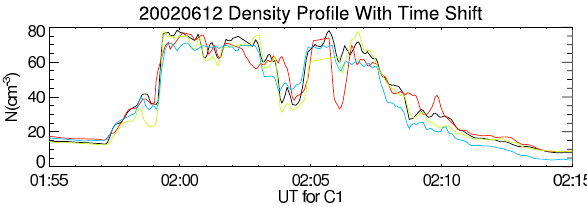
Fig. 7. Density profile during the outbound plume crossing between 01:55 and 02:15UT on 12 June 2002. C2–4 data are shifted by − 52, − 72 and − 36s relative to C1 data, respectively. Meaning of each colour is the same as Fig. 4.